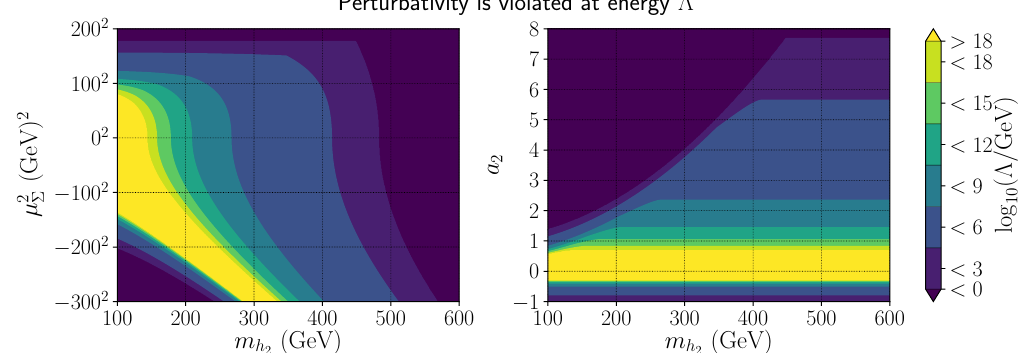
Figure 1. Contour plots showing the energies at which the perturbativity and perturbative uni- tarity constraints are violated as a function of m h and either (cid:22) 2 (left) or a 2 (right). The darkest (cid:6) 2 shade corresponds to the region of parameter-space where the conditions are not satis(cid:12)ed by the initial choice of parameters, with no running necessary. Conversely, the lightest shade corresponds to the region where the conditions are still satis(cid:12)ed after running the couplings up to very high energies. For each point we have set v (cid:6) = 0, and b 4 to the minimal value allowed by eq. (2.7). This choice of b 4 was found to maximise the energy at which the conditions were (cid:12)rst